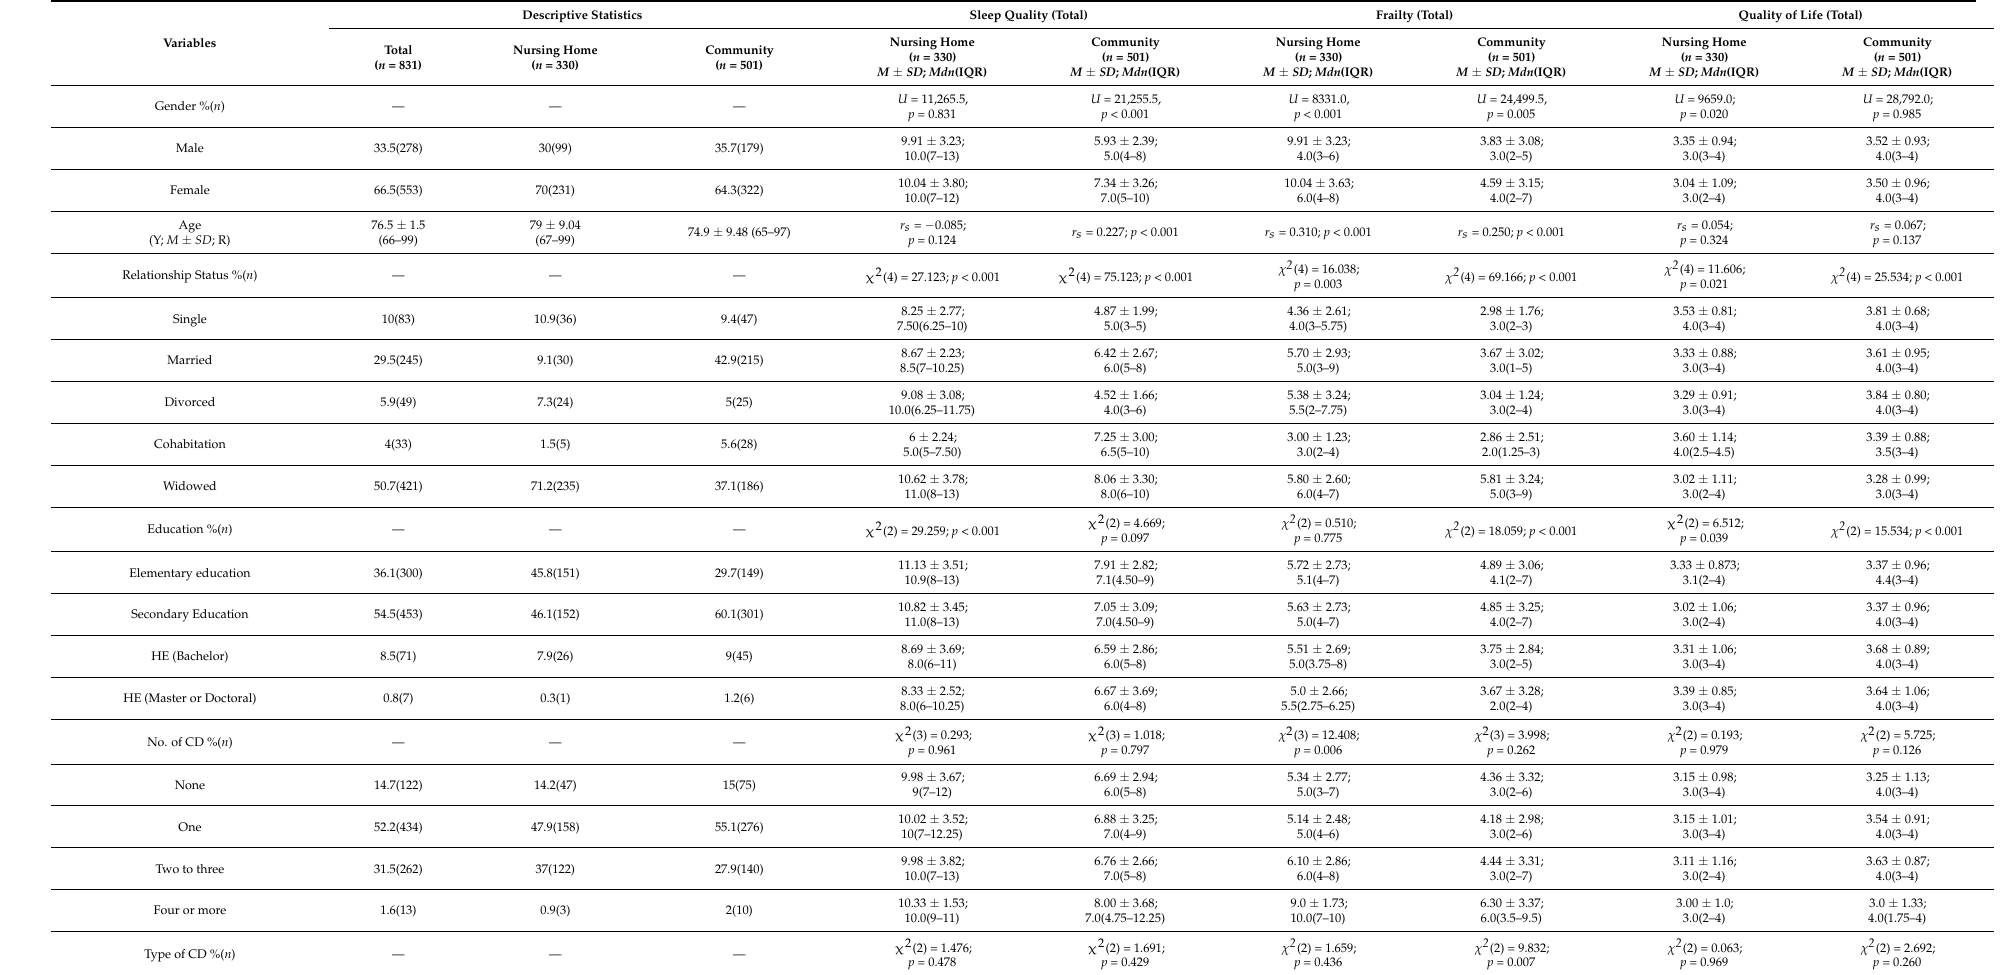
Table 1. Demographic variables and their relationship with sleep quality, frailty and quality of